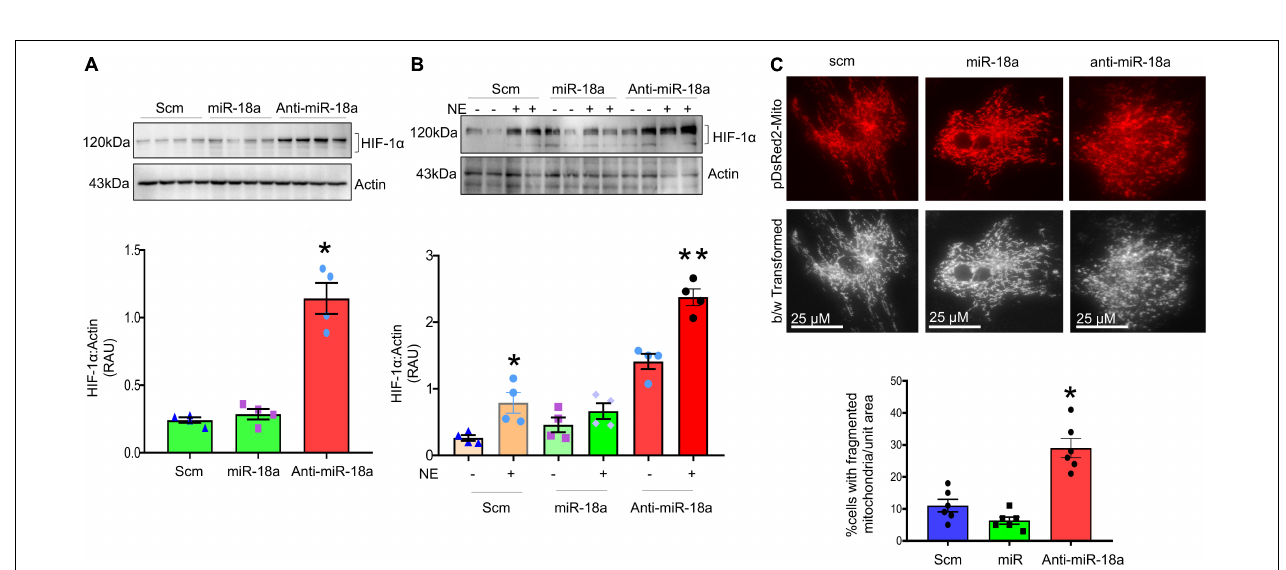
FIGURE 10 | MiR-18a-5p targets HIF-1 α and mitochondrial fission. (A) Western blot and quantification showing expression of HIF-1 α normalized to Actin in the H9c2 cardiomyocytes treated with scm, miR-18a-5p, and anti-miR-18a-5p. (B) Western blot and quantification showing expression of HIF-1 α normalized to Actin in H9c2 cardiomyocytes treated by scm, miR-18a-5p, and anti-miR-18a-5p, with NE or no NE. Values are mean ± SEM, * P < 0.05 vs. scm, ** P < 0.05 vs. miR-18a-5p. One-way ANOVA. (C) Top, live cell pDsRed2-Mito image of H9c2 cardiomyocytes treated with scm, miR-18a-5p, and anti-miR-18a-5p. Bottom, quantification of % number of cells with fragmented mitochondria (all globular) per unit areas in each group from six independent experiments.